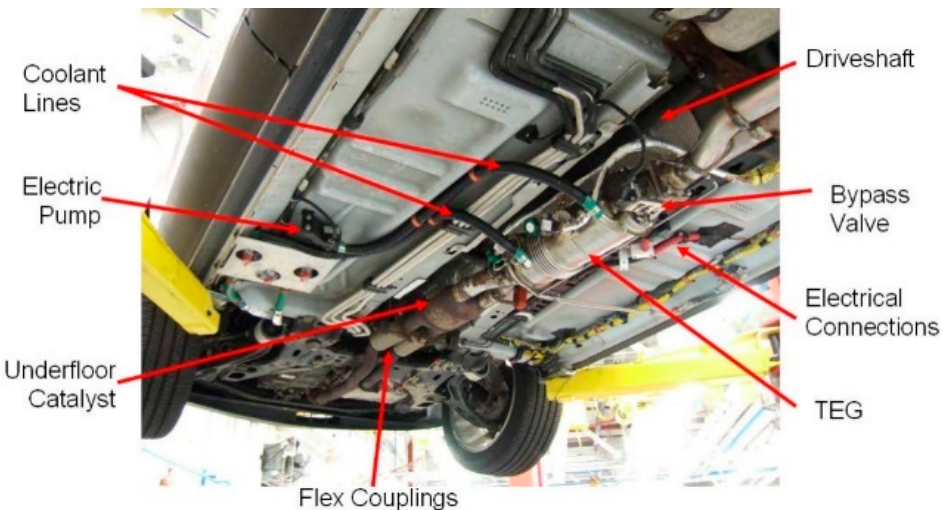
Figure 17. TEG integration into the exhaust line of the BMW X6 prototype vehicle [210].